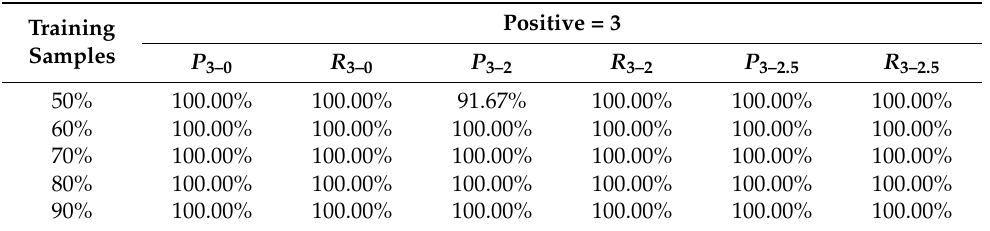
Table 7. Inter-class precision and recall of HY = 3 as positive.